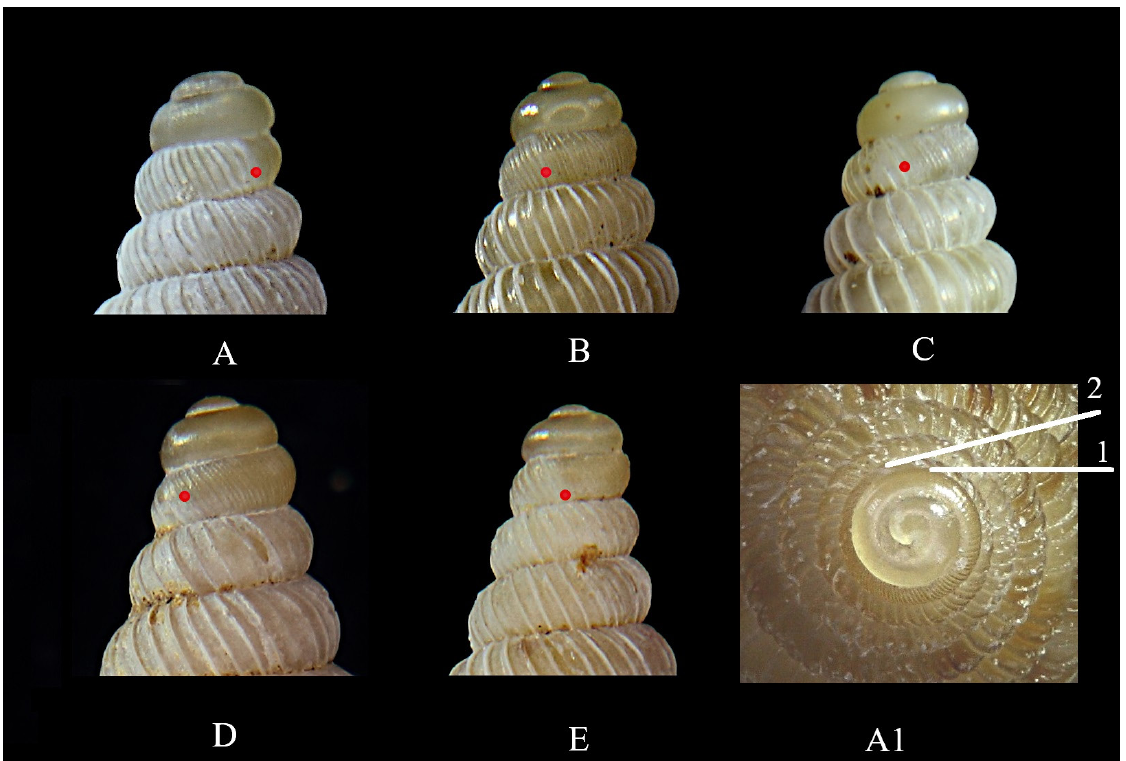
Fig. 3. Examples of protoconchs: the red dots mark the end of the protoconchs. A . Cochlostoma ( Clessiniella ) anomphale Boeckel, 1939 (EZ0034). A1 . Co. ( Cl. ) anomphale (EZ0034): 1 = end of the first smooth part of the protoconch; 2 = end of the protoconch. B . Co. ( Cl. ) tergestinum (Westerlund, 1878) (EZ0799). C . Co. ( Cl. ) villae (Strobel, 1851) (EZ0885). D . Co. ( Cl. ) waldemari (A.J. Wagner, 1897) (WdM6697). E . Co. ( Cl. ) stelucarum sp. nov.